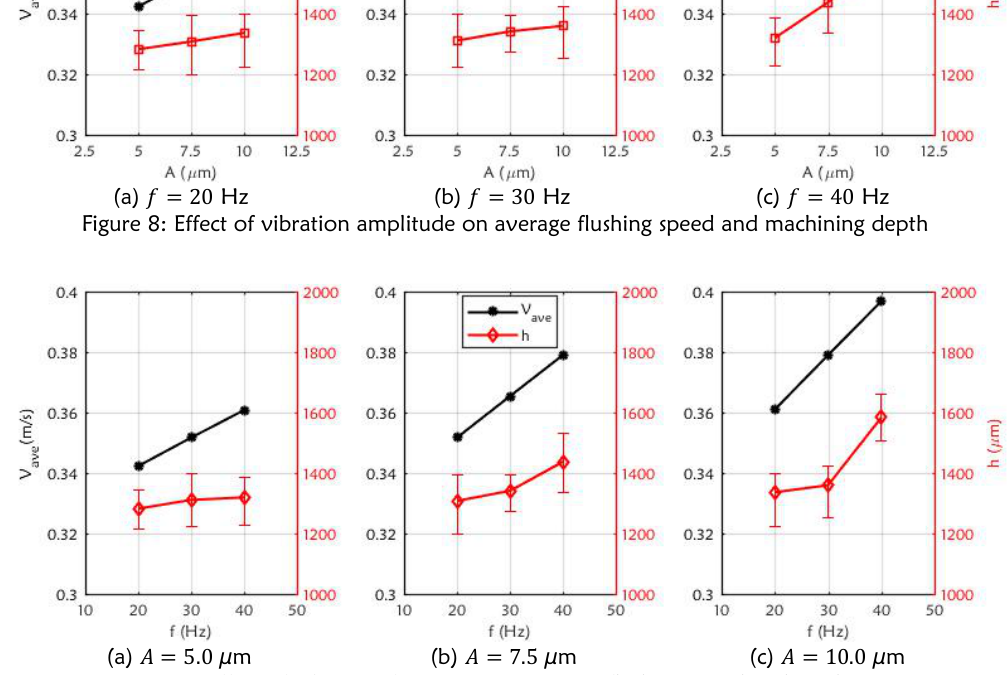
Figure 9: Effect of vibration frequency on average flushing speed and